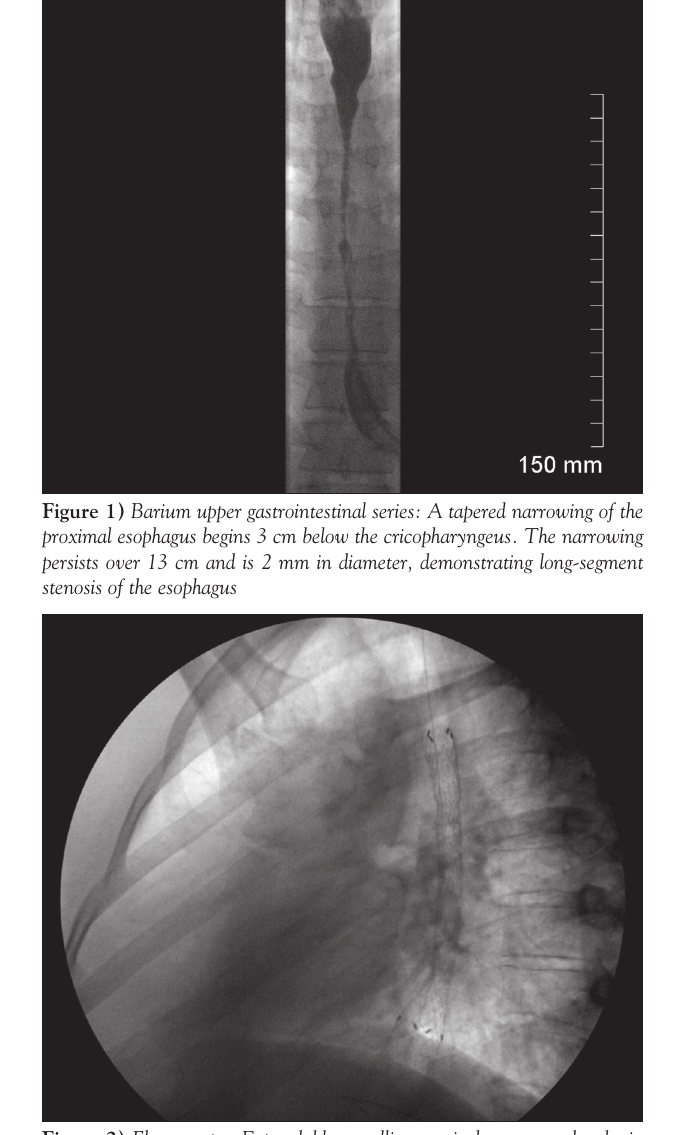
Figure 2) Fluoroscopy. Expandable metallic stent is demonstrated to be in satisfactory position after endoscopy and antegrade instrumentation of the midthoracic esophageal stricture including balloon